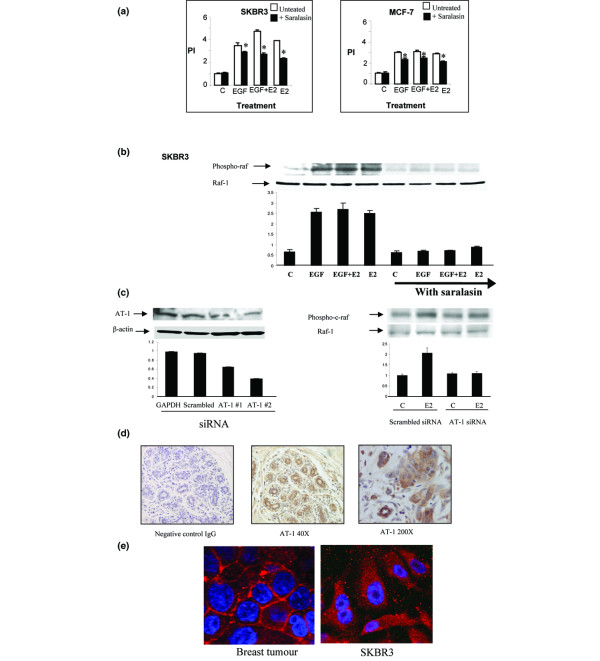
The role of the AT1 receptor in 17β-oestradiol and EGF-mediated cell proliferation and Raf phosphorylation in breast cancer cells. (a) SKBR3 and MCF-7 breast cancer cells pretreated with or without angiotensin II receptor antagonist saralasin (10-6 mol/l) 1 hour before 24 hours of incubation with EGF (10 ng/ml) and 17β-oestradiol (10-8 mol/l) alone and in combination. Cell proliferation assays were carried out using MTT thiozolyl blue. Proliferative index of the control group is standardized to 1. The results shown are expressed as mean ± standard error (n = 9). Statistical analysis was performed using Mann-Whitney U test (*P < 0.02 versus without saralasin). (b) Western blot analysis of phospho-Raf and total Raf in SKBR3 cells pretreated with or without the AT1 antagonist saralasin (10-6 mol/l) for 1 hour before 10 minutes of incubation with EGF (10 ng/ml) and 17β-oestradiol (10-8 mol/l) alone and in combination. Results are representative of those obtained in three separate experiments. (c) Western bolt analysis of AT1 and phospho-Raf in SKRB3 cells transiently transfected with GAPDH siRNA, scrambled siRNA, or AT1 (#1 or #2) siRNA before treatment with 17β-oestradiol (10-8 mol/l) for 10 minutes. Results are representative of those obtained in three separate experiments. Optical density readings of control values were normalized to 1 and experimental groups were expressed as a ratio. Values are expressed as mean ± standard error (n = 3). (d) Immunohistochemistry was carried out for AT1 receptor on primary human breast cancer tissue (7 μm). Negative control was matched IgG. The slides were counterstained with Mayer's haematoxylin solution and were viewed under a light microscope at 40× and 200× magnifications. Positive cells stained brown against a blue background. (e) Immunofluorescence studies of AT1 receptor in human primary tumour breast cancer tissue (7 μm) and SKBR3 breast cancer cells. Slides were viewed under a confocal microscope at 630×. AT1, angiotensin II type 1; E2, 17β-oestradiol; EGFR, epidermal growth factor receptor; siRNA, small interfering RNA.